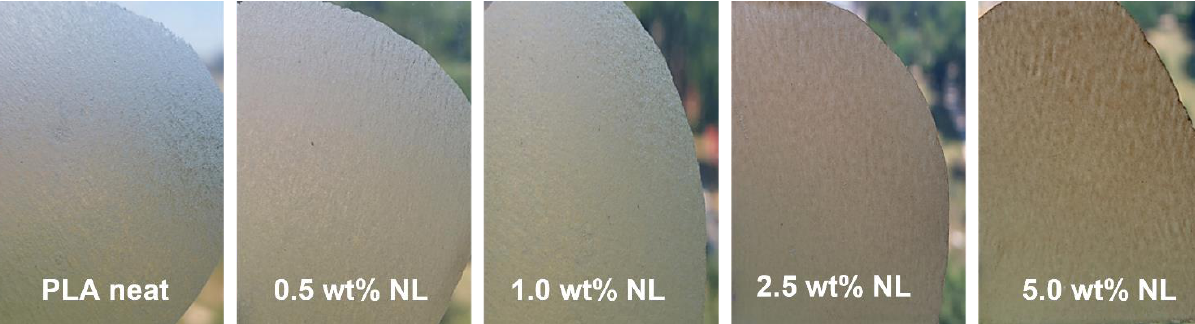
Figure 16. PLA – nanolignin films with different NL content.